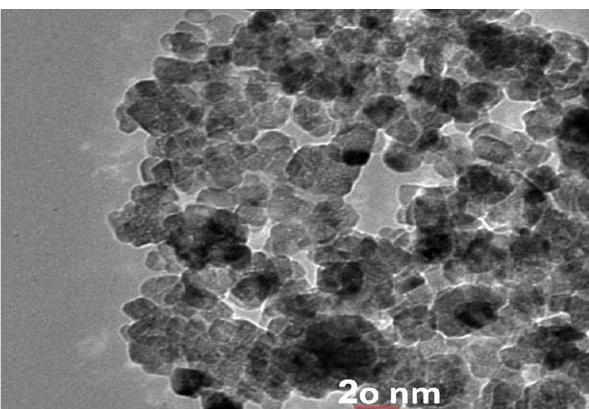
particles used 3